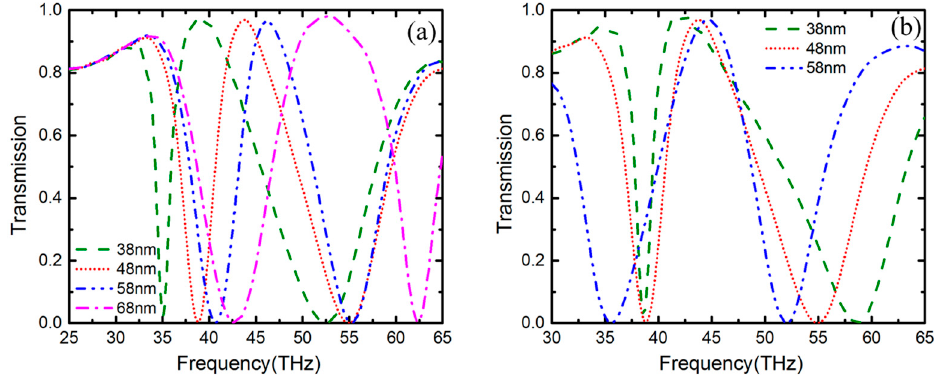
Figure 5. Transmission spectrum corresponding to different widths of the gap, 38, 48, 58 and 68 nm, respectively. ( a ) Keeping the geometric parameters of OR same and changing the radius of IR. ( b ) Keeping the geometric parameters of IR same and changing the radius of OR.